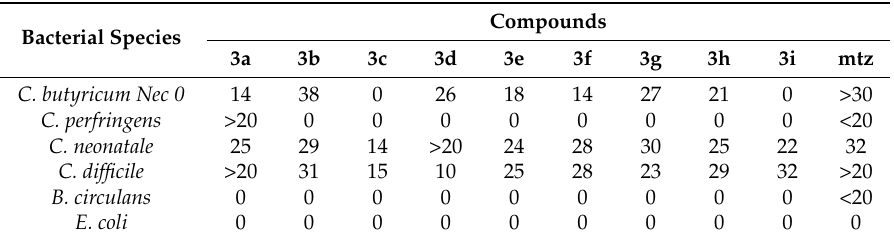
Antibacterial activity of molecules 3a – 3i obtained with the first regioselective Suzuki-Miyaura reaction.